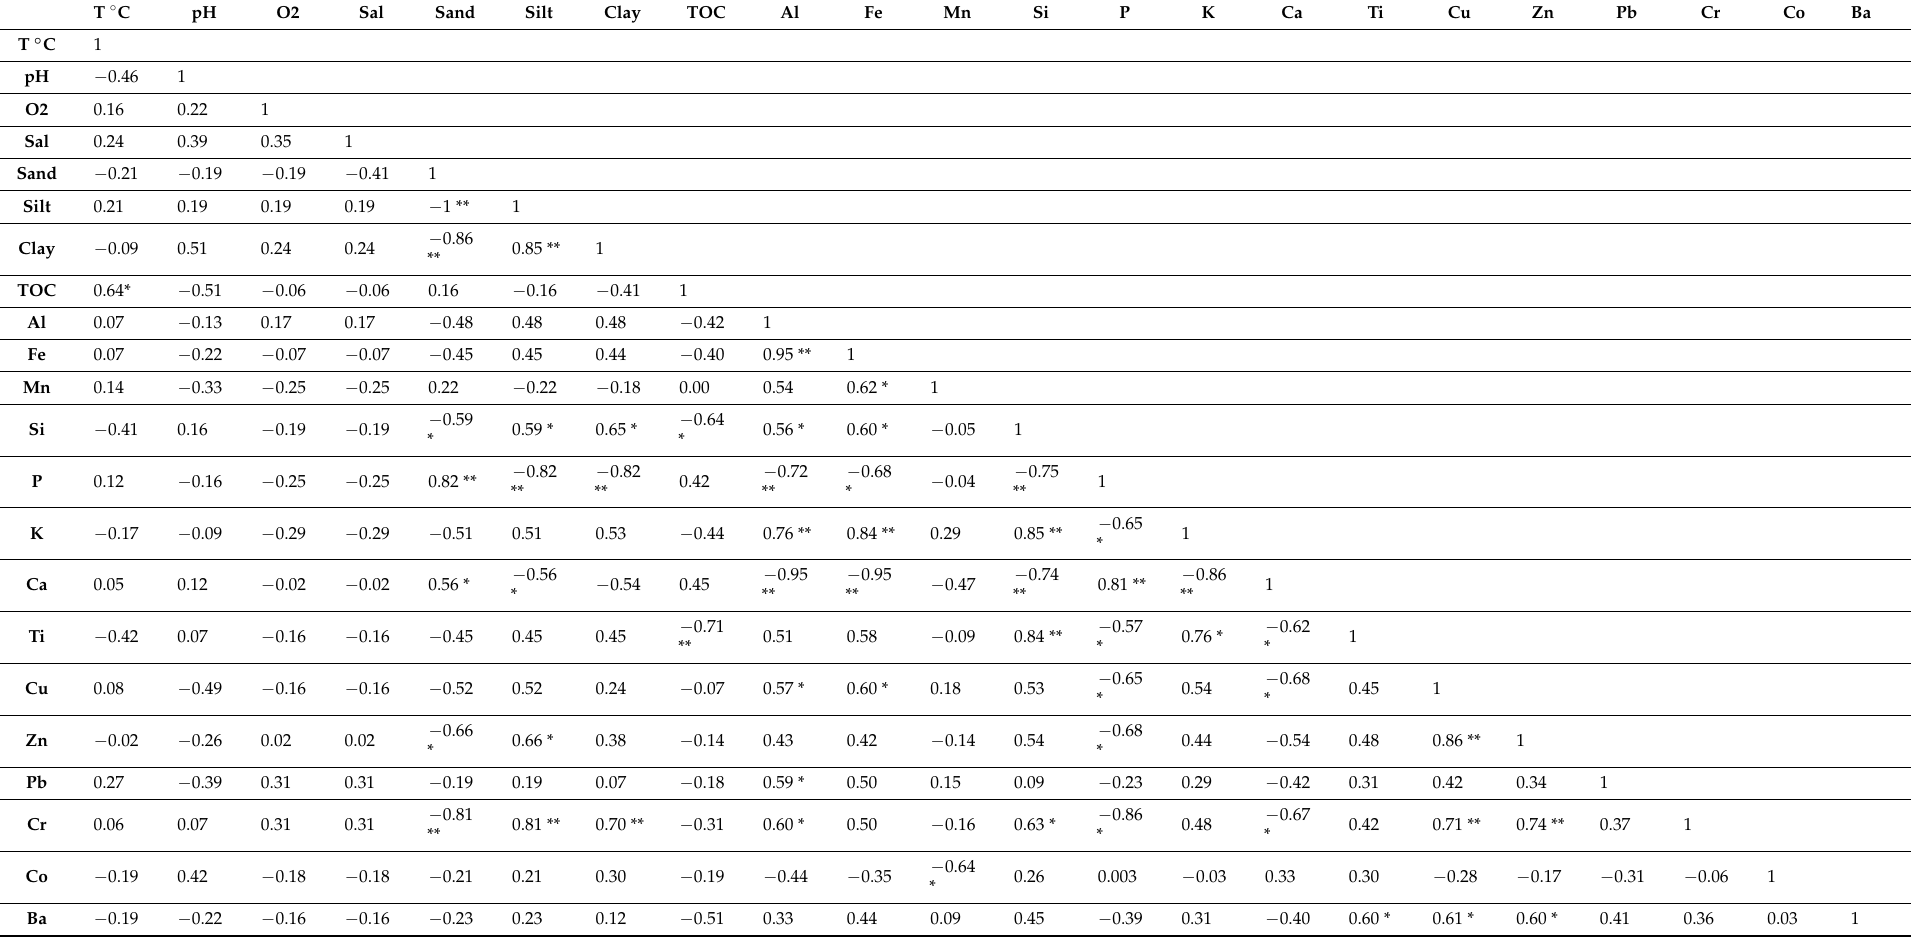
Table 4. Spearman’s correlation coefficients of the major and trace elements, grain size fractions, and TOC in sediment and the physicochemical parameters of the surface waters in Marchica